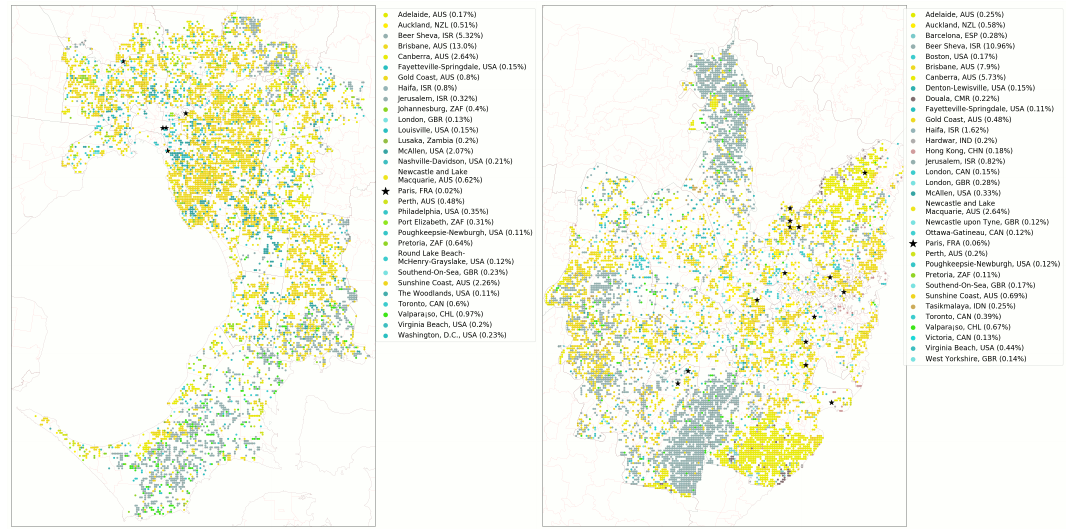
Figure 3. Predicted similar cities using the GM neural network (filtering out probabilities lower than 50%). Top predicted cities plotted (using Figure 2 colour scheme) for Melbourne evaluation locations ( left ) and Sydney ( right ). Predicted Paris locations marked with black